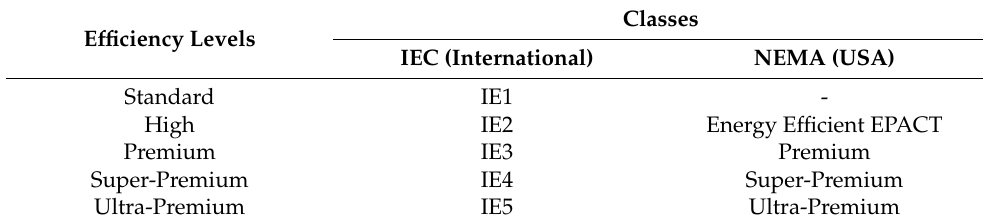
Table 2. Efficiency classes and levels for electrical